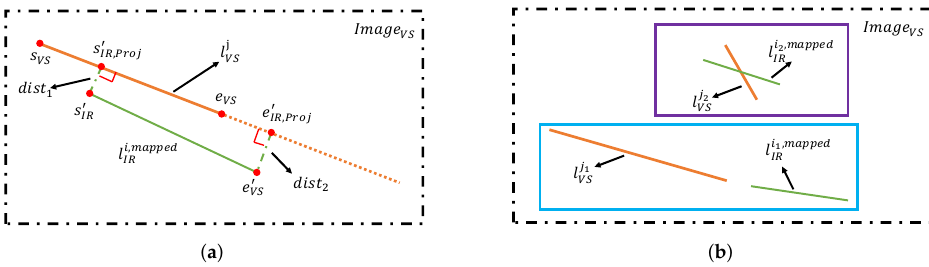
Figure 6. Geometric constraints illustration ( a ) and two examples of false match ( b ) that only satisfy one of the two geometric constraints. (The matching candidate enveloped with a blue rectangle only satisfies the point-to-line constraint. Another candidate in the purple rectangle only agrees with the overlap